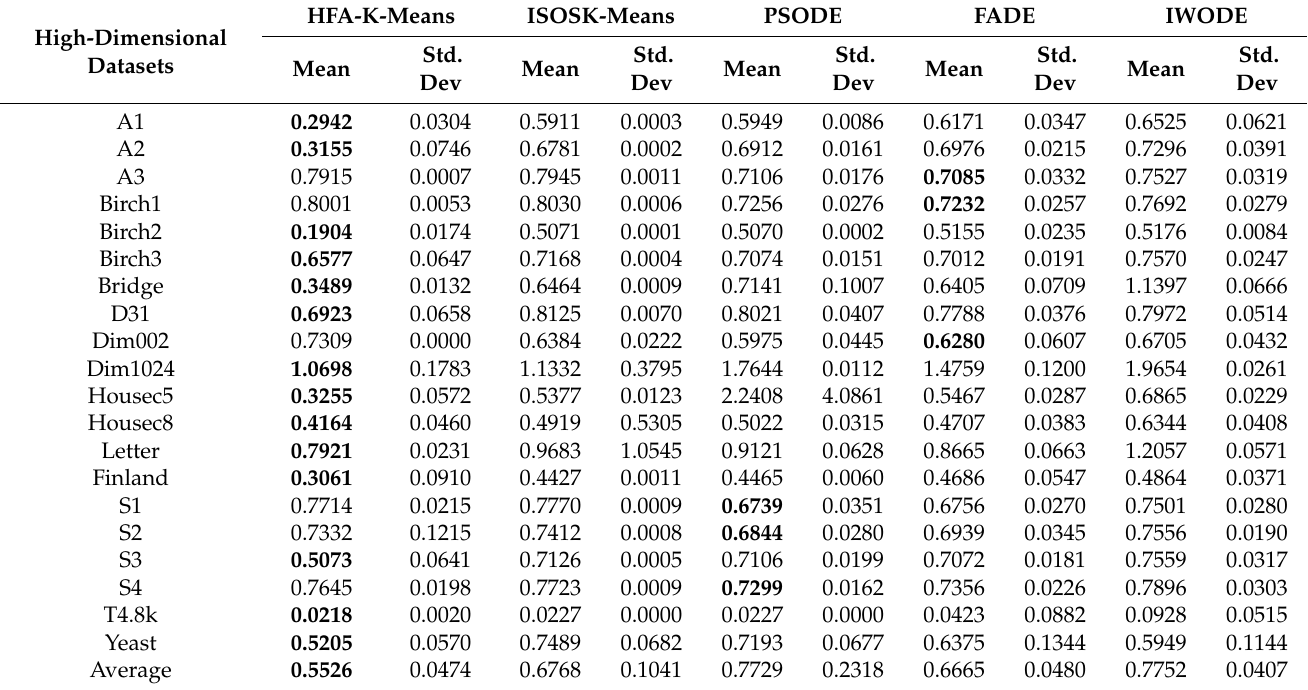
Table 8. Comparison of HFA-K-means with ISOS-K-means, PSODE, FADE, and IWODE on 20 high- dimensional datasets.